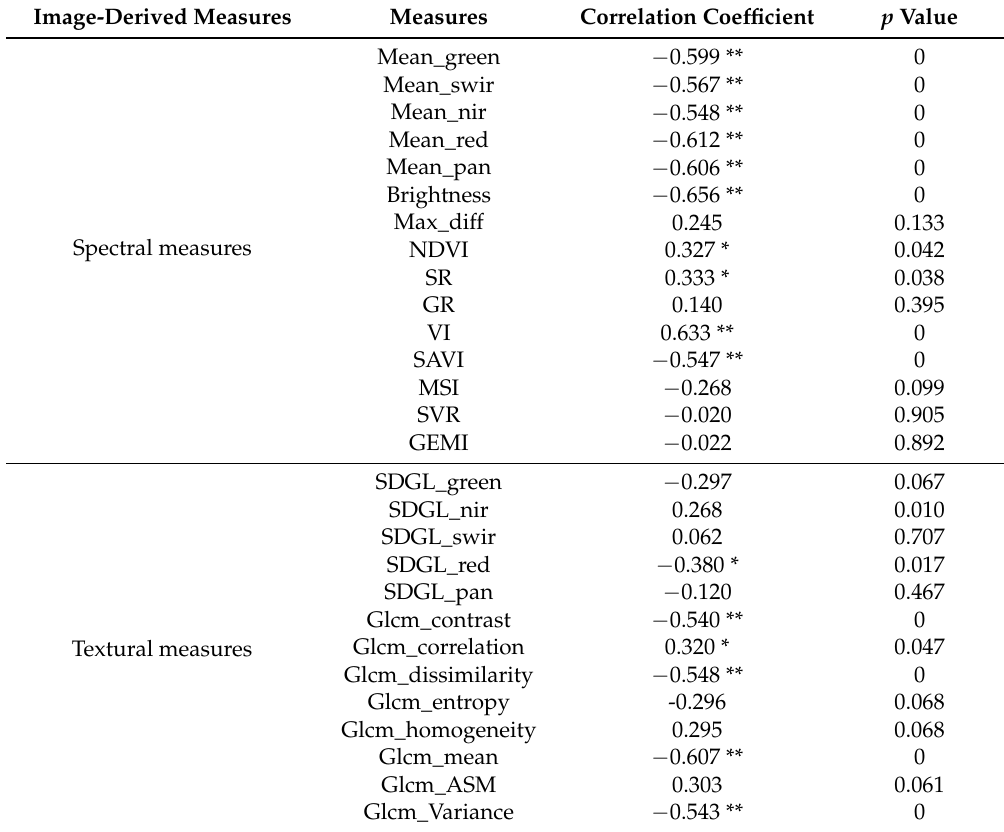
Table 7. Pearson correlation coefficients between the image-derived measures and the FFHI. Image-Derived Measures Measures